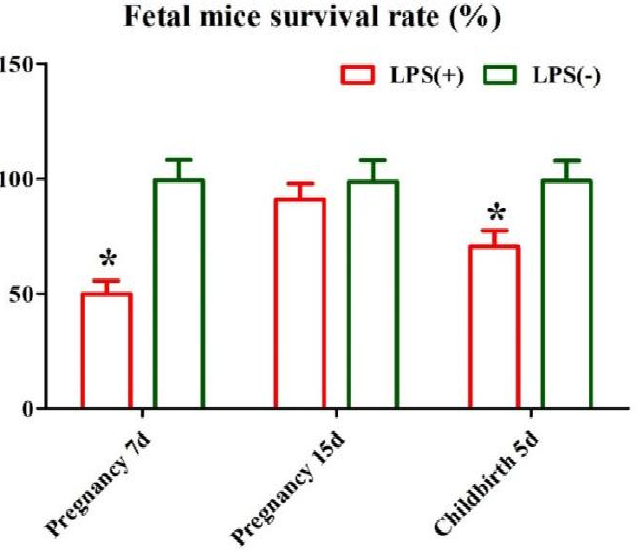
Figure 5. Effect of LPS on reproductive performance of female mice. * Statistical difference between LPS (+) and LPS (-) groups in the same period ( p < 0.05)).